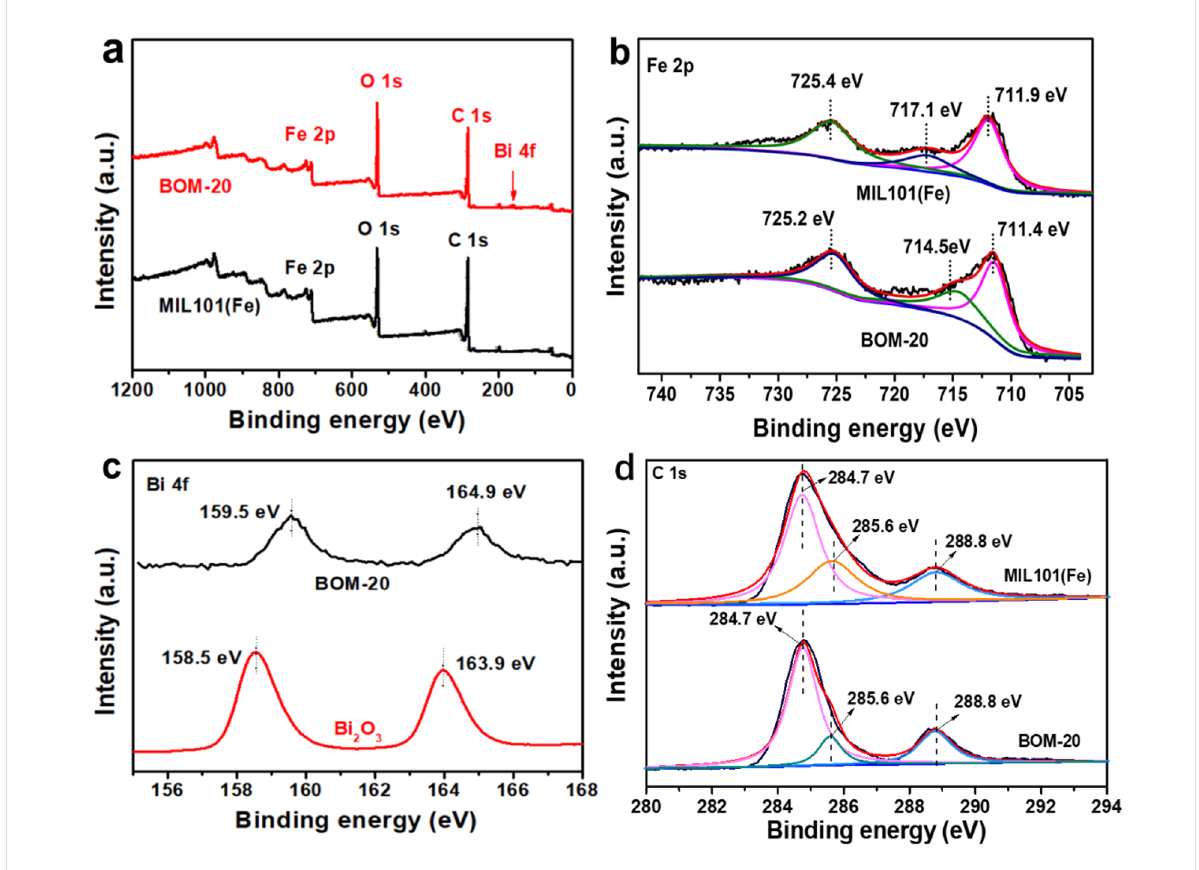
Figure 4: (a) XPS survey spectra of BOM-20 and high-resolution XPS spectra of (b) Fe 2p; (c) Bi 4f; and (d) C 1s.